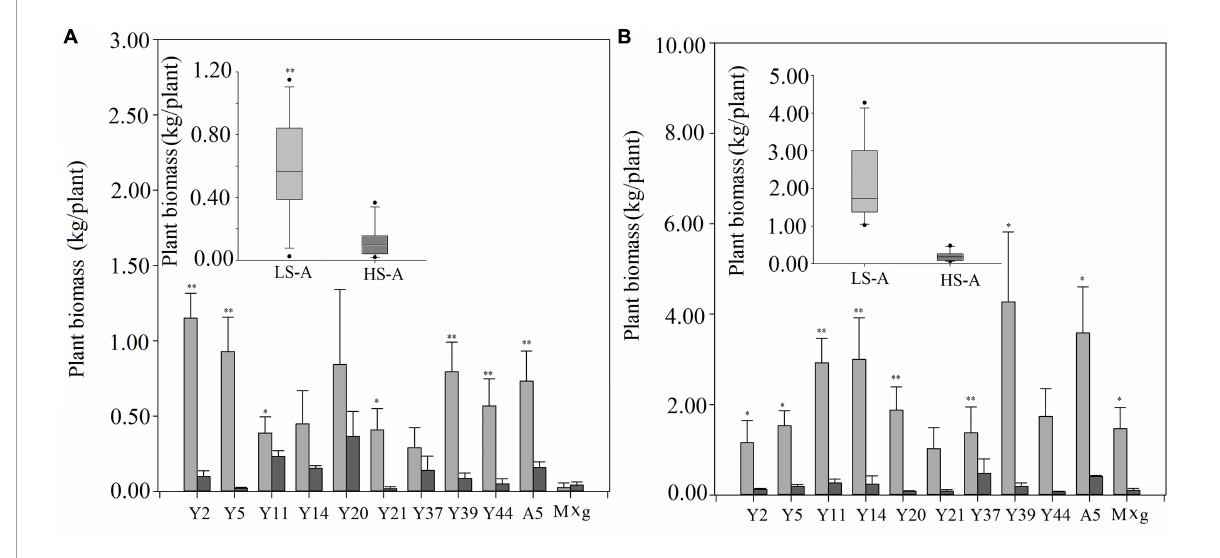
FIGURE2 Plant biomass under low saline–alkaline soil (LS-A) (the light bars) and high saline-alkaline soil (HS-A) (the dark bars), of 11 genotypes of Miscanthus in 2017 (A) and 2018 (B) . Significance is denoted by ∗ P < 0.05 and ∗∗ P <